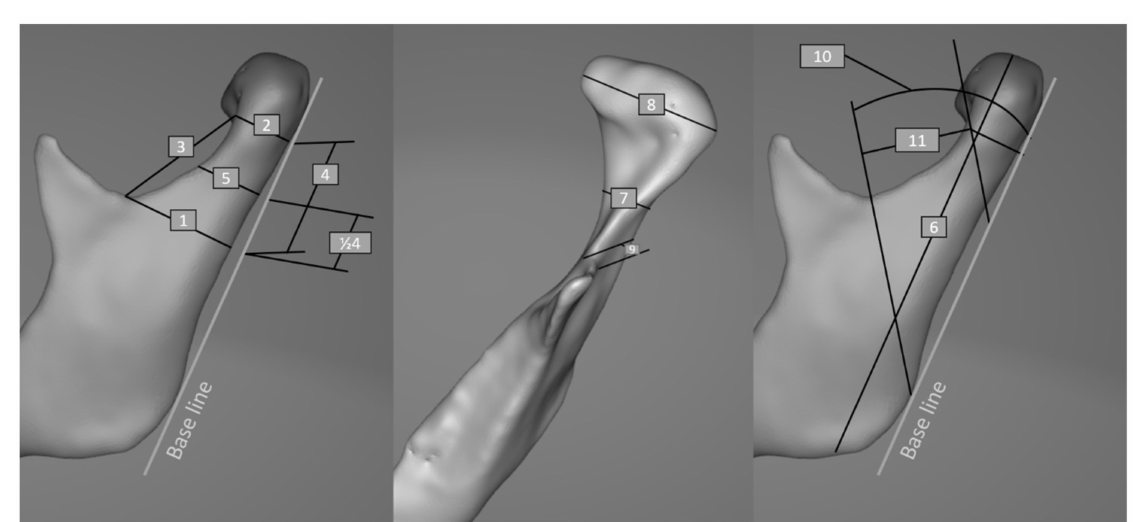
Figure 1. Anatomical measurements: (1) length_neck_basal, (2) length_neck_top, (3) distance_sigmoidnotch-neck top, (4) height_neck, (5) length_neck_middle, (6) the Ramus height, (7) width_neck_basal, (8) width_head, (9) thick- ness_sigmoid_notch, (10) angle_posteriorline-notchpoint, (11)